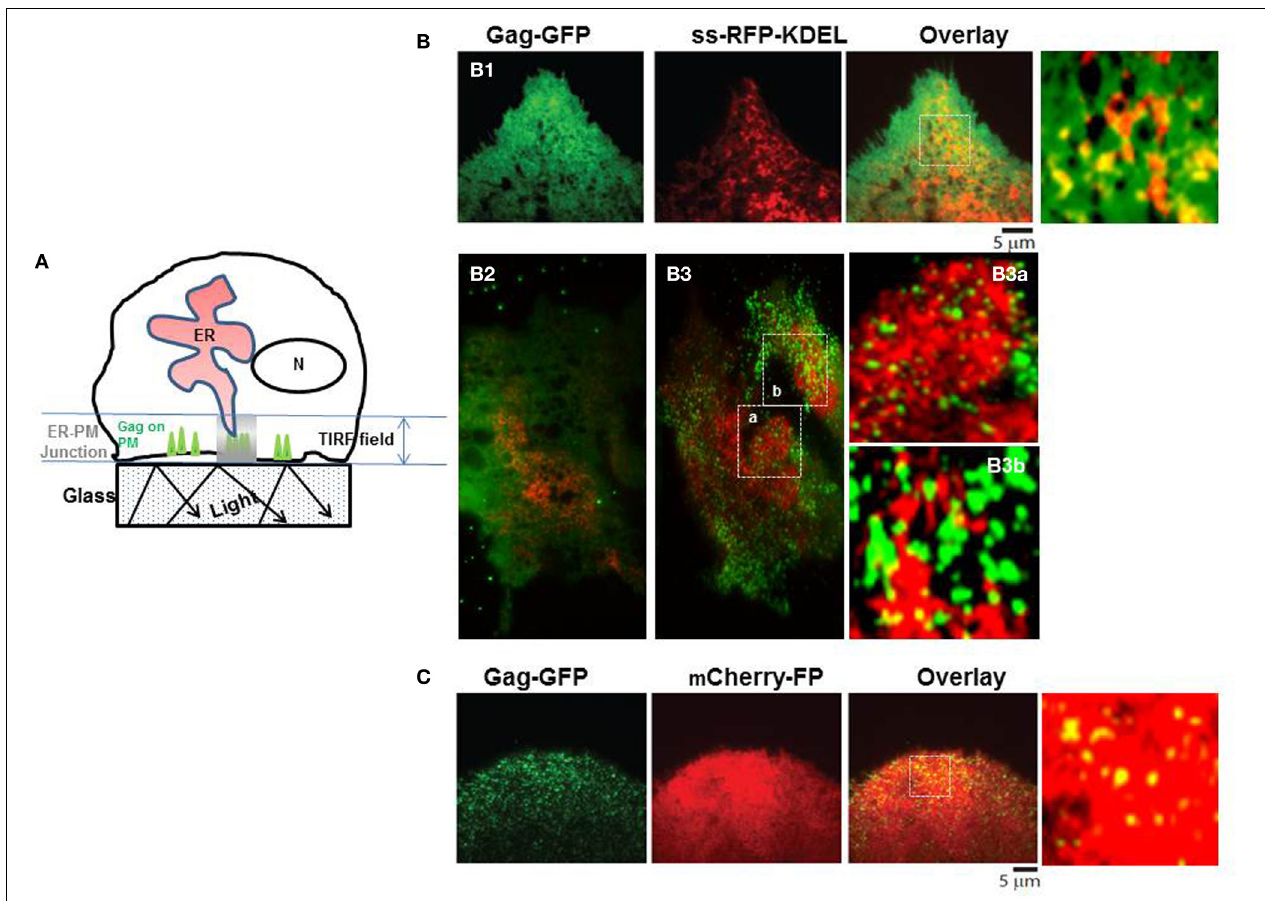
FIGURE 4 | TIRF microscopy of peripheral ER in proximity to Gag at the plasma membrane. (A) Schematic drawing depicting area of signal capture in TIRF field. Panels (B,C) show representative images of Gag-GFP fluorescence (green) at an early (8h, B1 ) and a later (24h, B2,B3,C) time